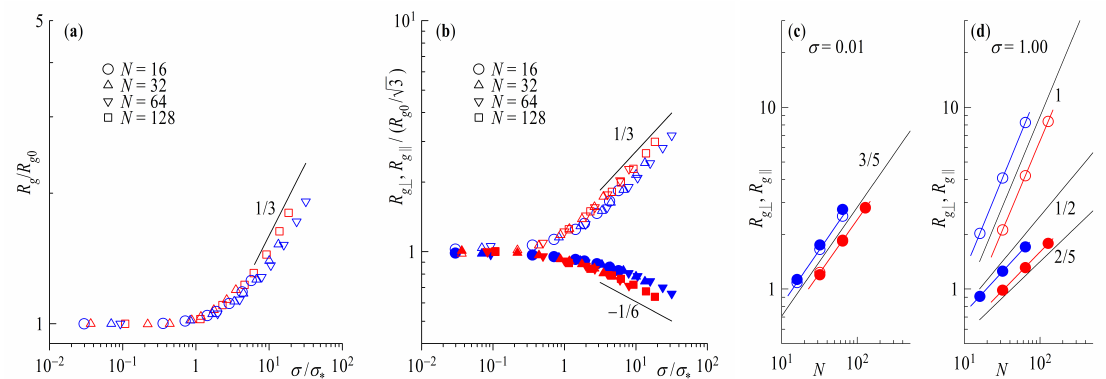
Figure 7. ( a ) Radius of gyration R g scaled by the R g 0 of infinite dilution as a function of the surface overlap concentration σ / σ ∗ . ( b ) Parallel R g (cid:107) (full symbols) and perpendicular R g ⊥ (empty symbols) √ component of the radius of gyration scaled by R g 0 / 3 of infinite dilution as a function of the surface overlap concentration σ / σ ∗ . R g (cid:107) (full symbols) and R g ⊥ components (empty symbols) as a function of chain length N for ( c ) surface coverage σ = 0.01 and for ( d ) σ = 1.00. Red symbols are rings and blue for tails. Straight lines indicate power laws with scaling exponents shown next to the